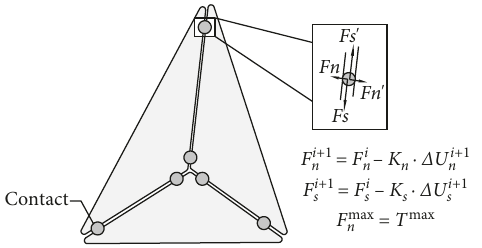
Figure 3: Force equation of i th step and ( i +1) th step of